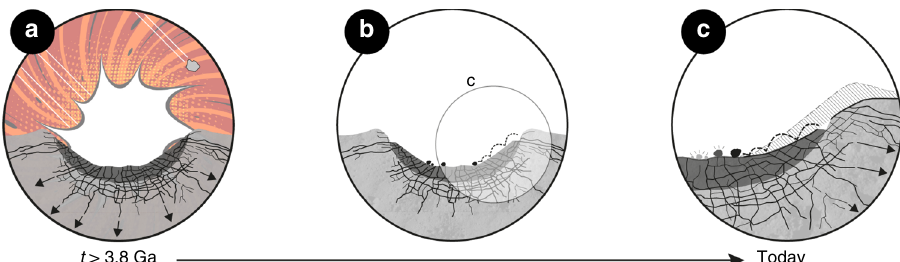
Fig. 4 Conceptual model of lunar mass wasting. a Impacting bodies batter the lunar surface, creating topography (craters and associated terrain) as well as intense fracturing of the bedrock. b Impact craters feature radial, concentric, shear, and spalling fractures that cause the release of boulders — rockfalls — over time. c The extent of fracture networks is suf fi cient to drive rockfalls over billions of years. Fracture distribution pattern taken from ref.